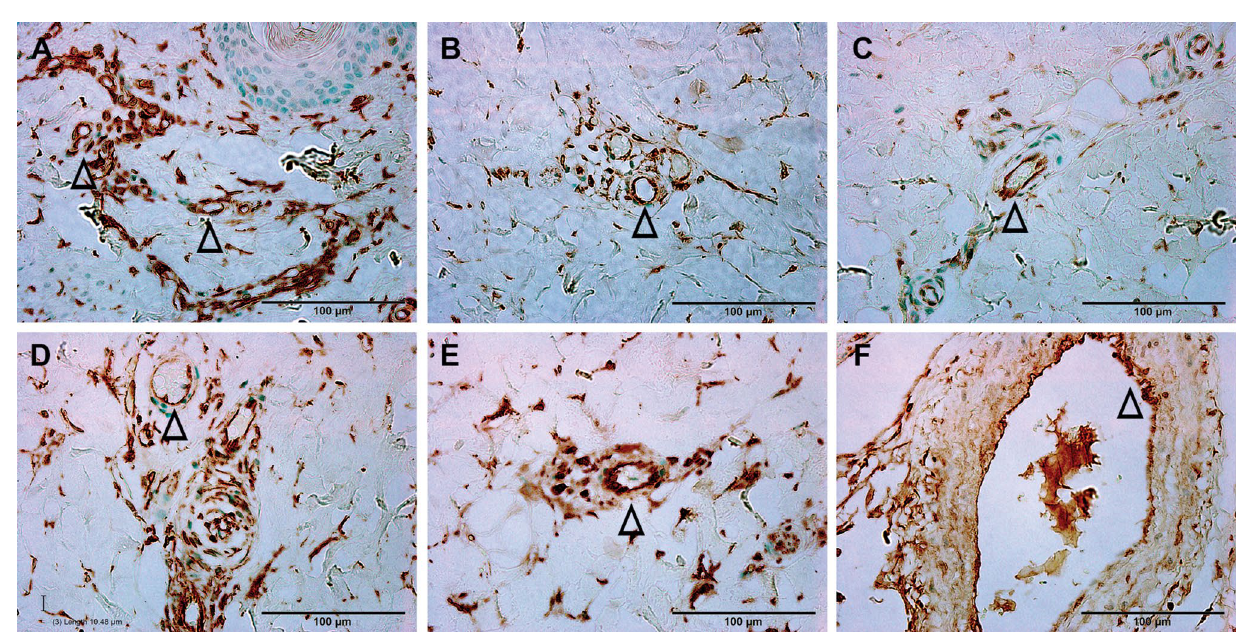
Figure 6. High power images of vimentin IHC shown in the boxes outlined in the corresponding micrographs in Fig. 5 and representing the burn sites of porcine burn wounds harvested at 0 h ( A ), 0.5 h ( B ), 1 h ( C ), 2 h ( D ), 4 h ( E ) and 24 h ( F ), respectively. ∆, patent blood vessels Bar = 100 µm ( A to F